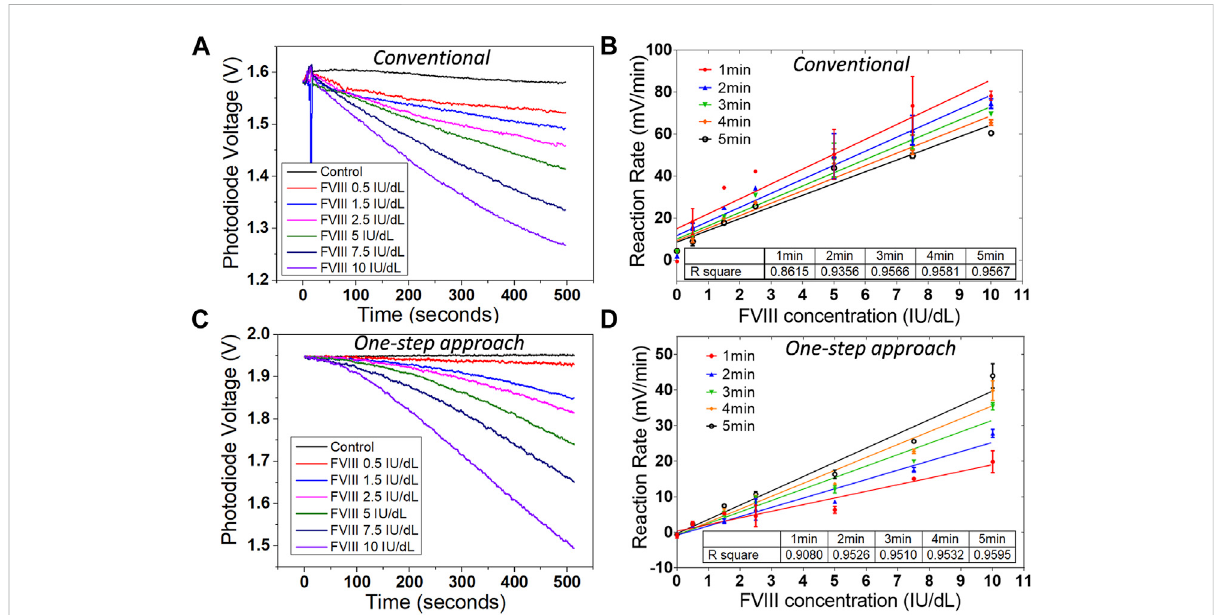
FIGURE 4 Results from diluted plasma on the sensing platform. (A) Reaction curves, and (B) reaction rates from six concentrations of diluted plasma samples on the sensing platform with conventional chromogenic method. (C) Reaction curves, and (D) reaction rates from six concentrations of diluted plasma samples on the sensing platform with the one-step chromogenic approach. Data are the mean ± SEM with three repeated measurements.